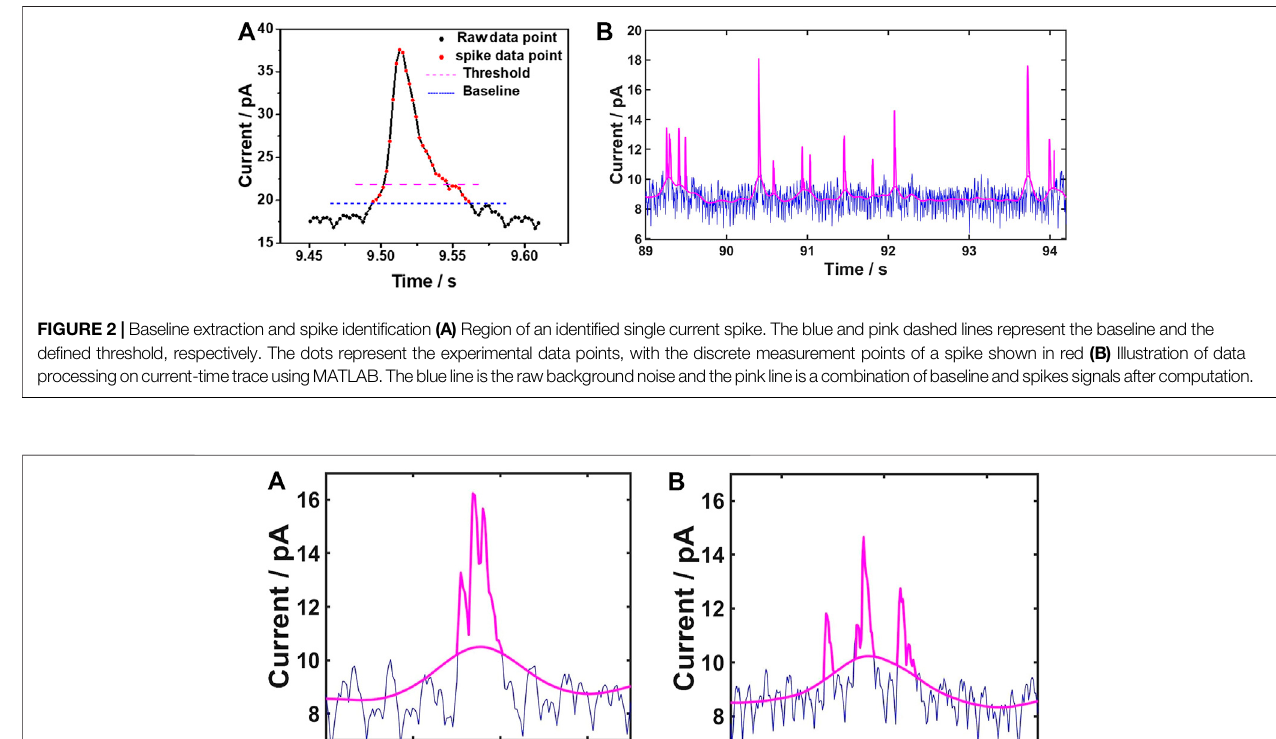
Frontiers in Chemistry |